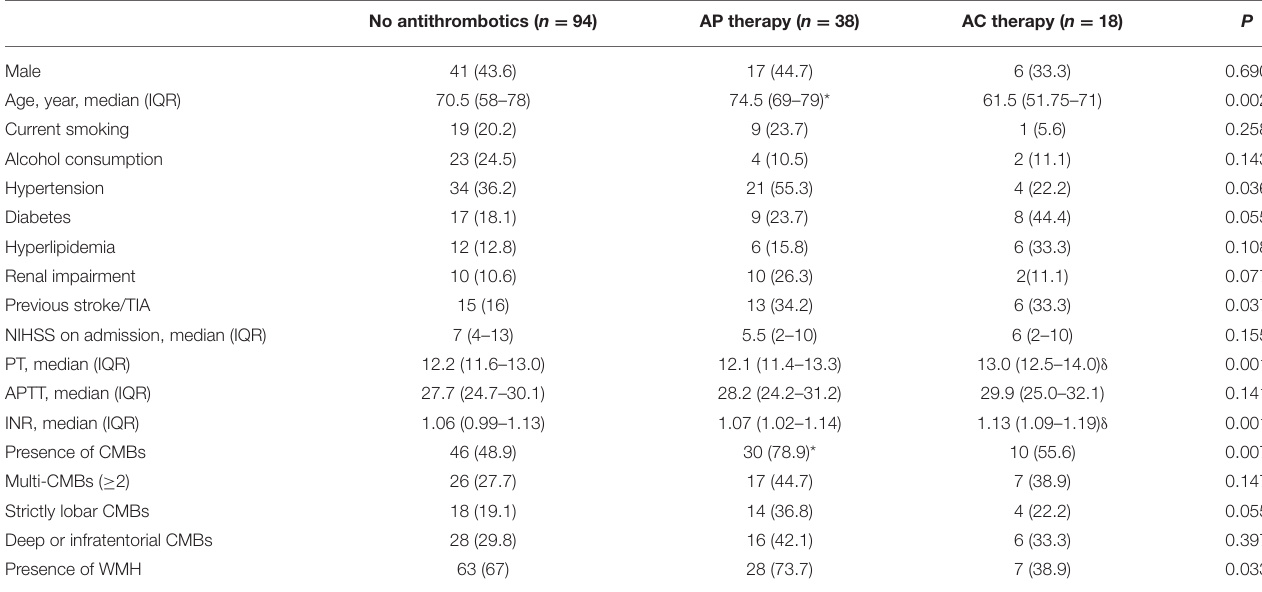
TABLE 2 | Baseline characteristics of patients by different antithrombotic